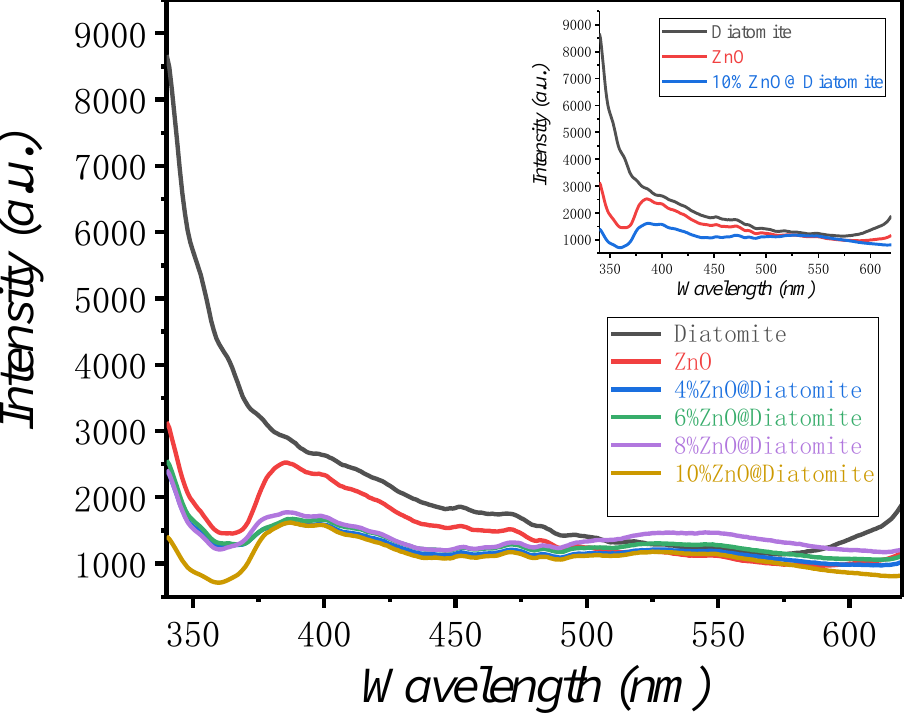
Figure 8. PL spectra of ZnO, diatomite, and X% ZnO@diatomite.